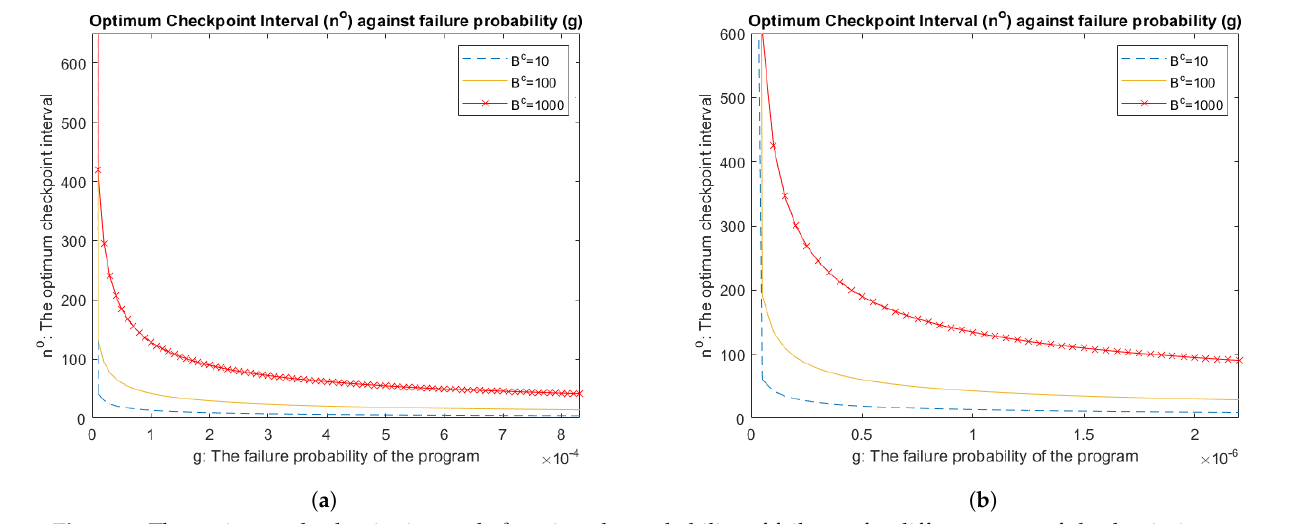
Figure 6. The optimum checkpoint interval n o against the probability of failure g for different cases of checkpointing cost B c , for a program of small ( a ) size with Y = 10 4 , and a medium sized program in ( b ) with Y = 10 5 .